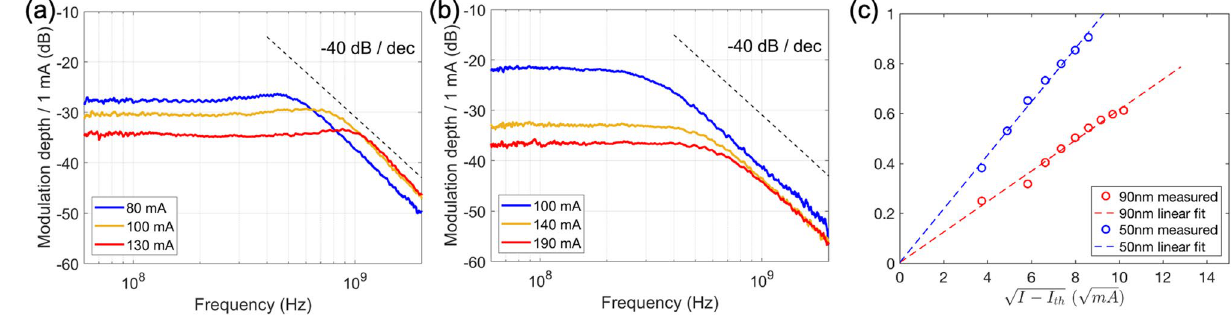
Figure 4. ( a ) The intensity modulation response of the 50 nm QNCL laser at different bias currents. ( b ) The intensity modulation response of the 90 nm QNCL laser at different bias currents. Measured using an HP8722C (50 MHz–40 GHz) and Optilab BPR-20-M (Up to 20 GHz). ( c ) Relaxation resonance frequencies of the 50 nm I th . and 90 nm QNCL lasers as a function of √ I −